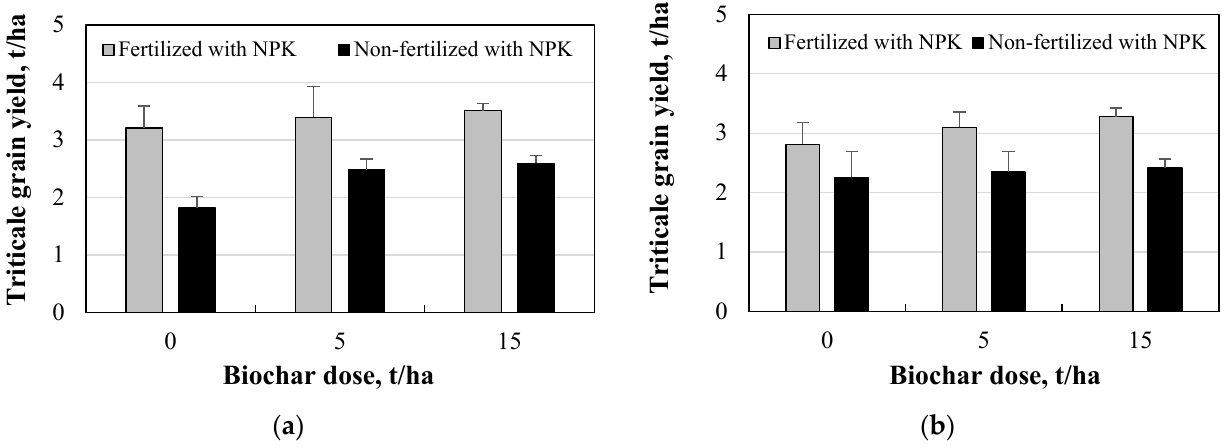
Figure 11. Triticale grain yield of standard moisture: ( a ) M—direct drilling; ( b ) S—shallow plough- less